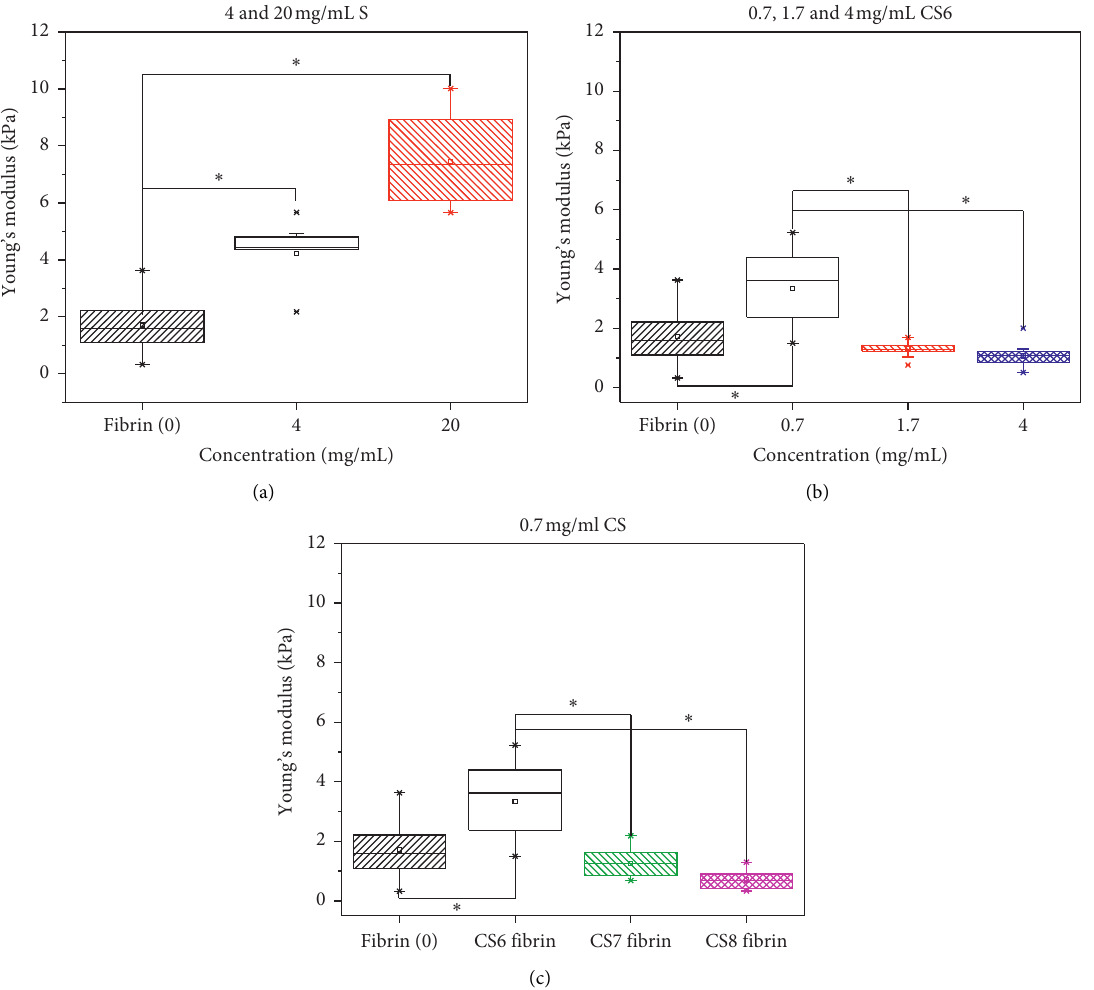
Figure 4: Young’s modulus of fibrin hydrogels modified with S and CS materials compared with native fibrin (0). S materials (4 and 20 mg/ mL) (a), CS6 materials (0.7, 1.7 and 4mg/mL) (b), and CS6, CS7, and CS8 materials (0.7mg/mL) (c). ∗ Different at a significance level of 0.005. Native fibrin n � 9; S and CS modified fibrin n �